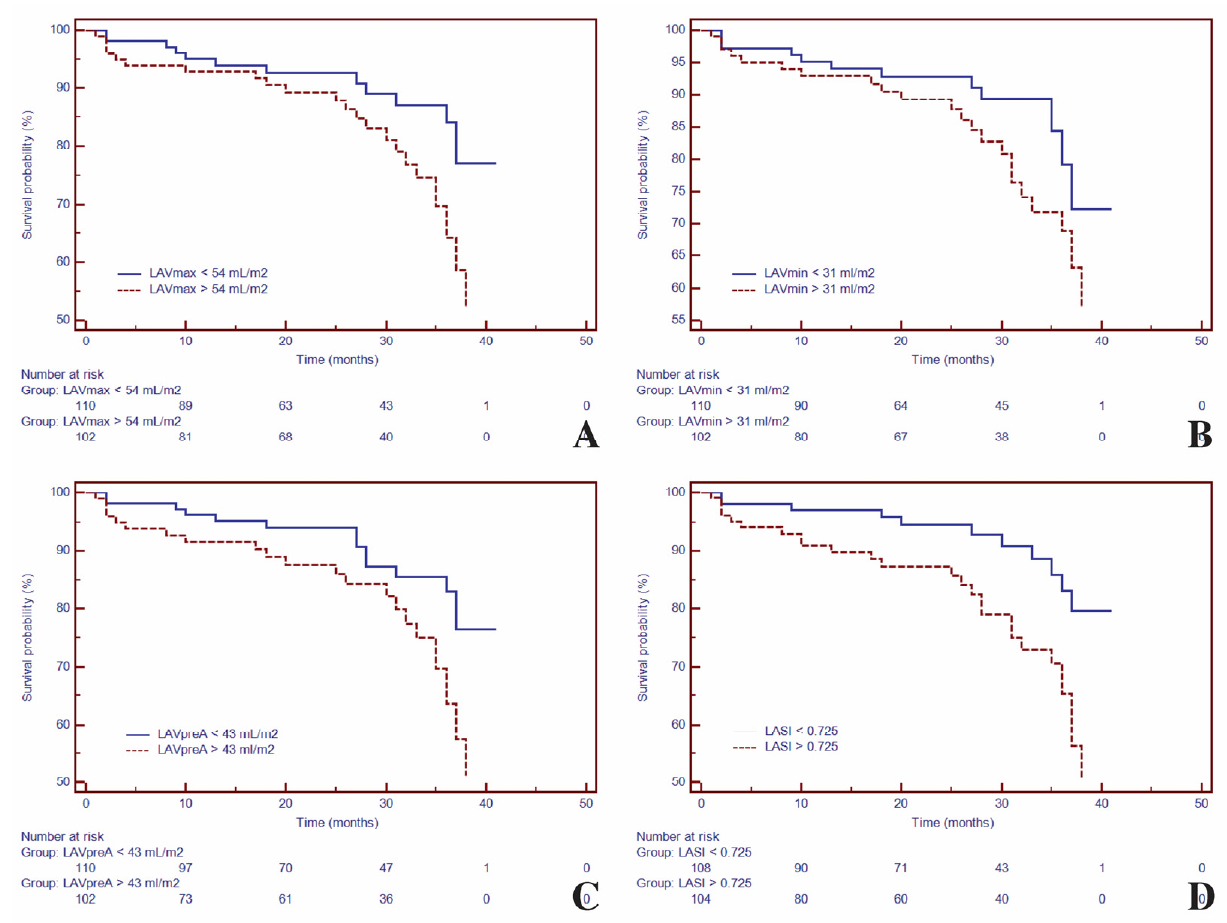
Figure 2. Kaplan–Meier curves for time to event analysis of: LAV max ( A ), LAV min ( B ), LAV pre-A ( C ) and LASI ( D ). Abbreviations: LAV max , maximum left atrial volume; LAV min , minimum left atrial volume; LAV pre-A , pre-atrial contraction left atrial volume; LASI, left atrial sphericity index.